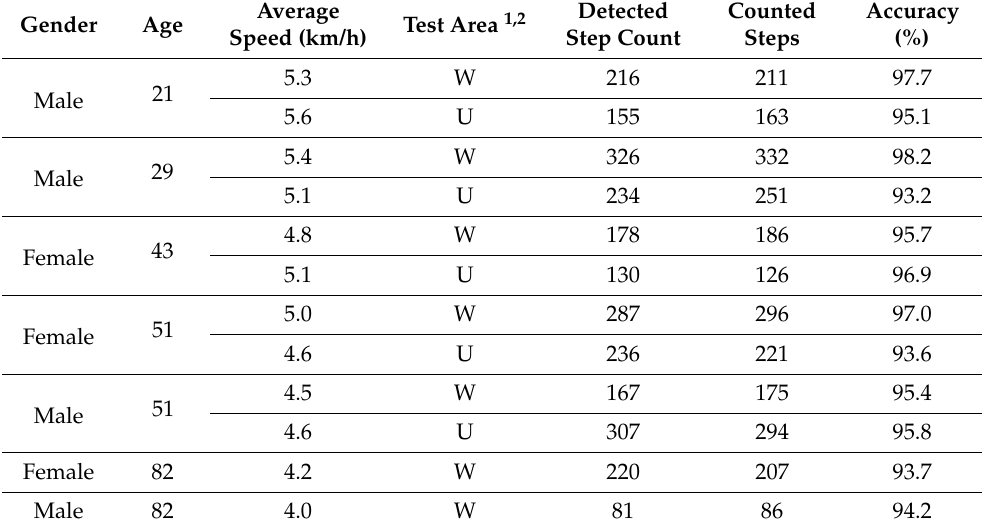
Table 1. Worst test results in a set of three trials for all volunteers per each test area. Gender